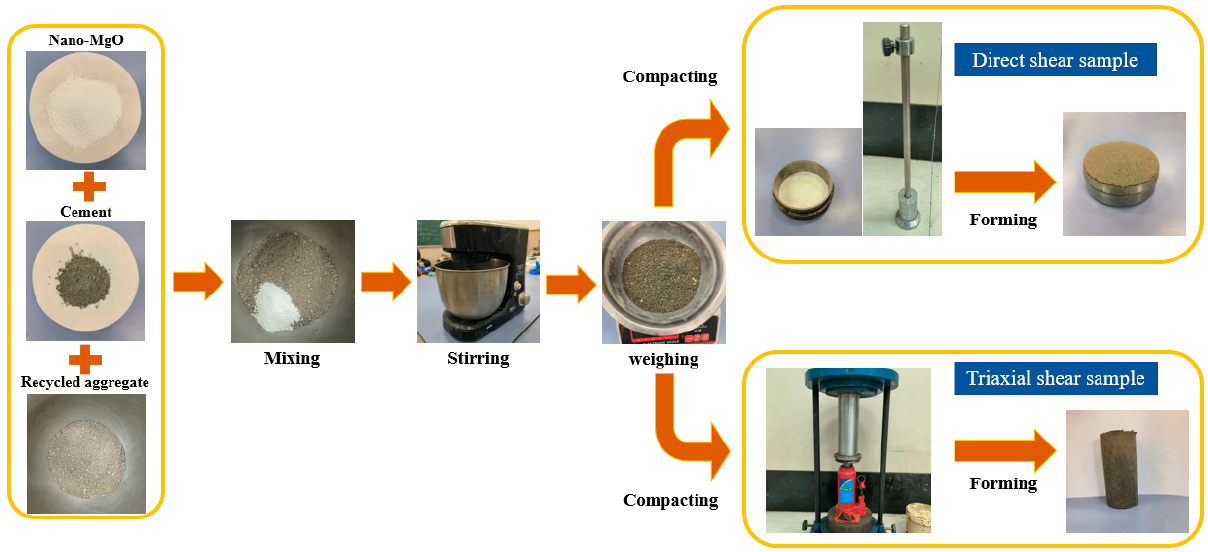
Figure 1. Sample preparation process.